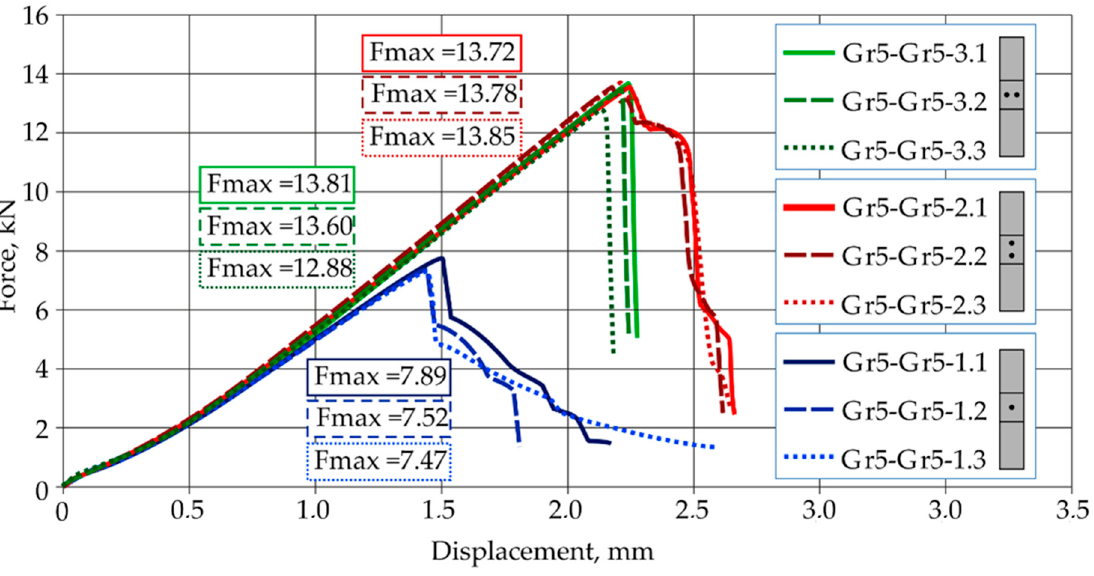
Figure 5. Force-displacement diagram from tensile shear test of Grade5–Grade 5